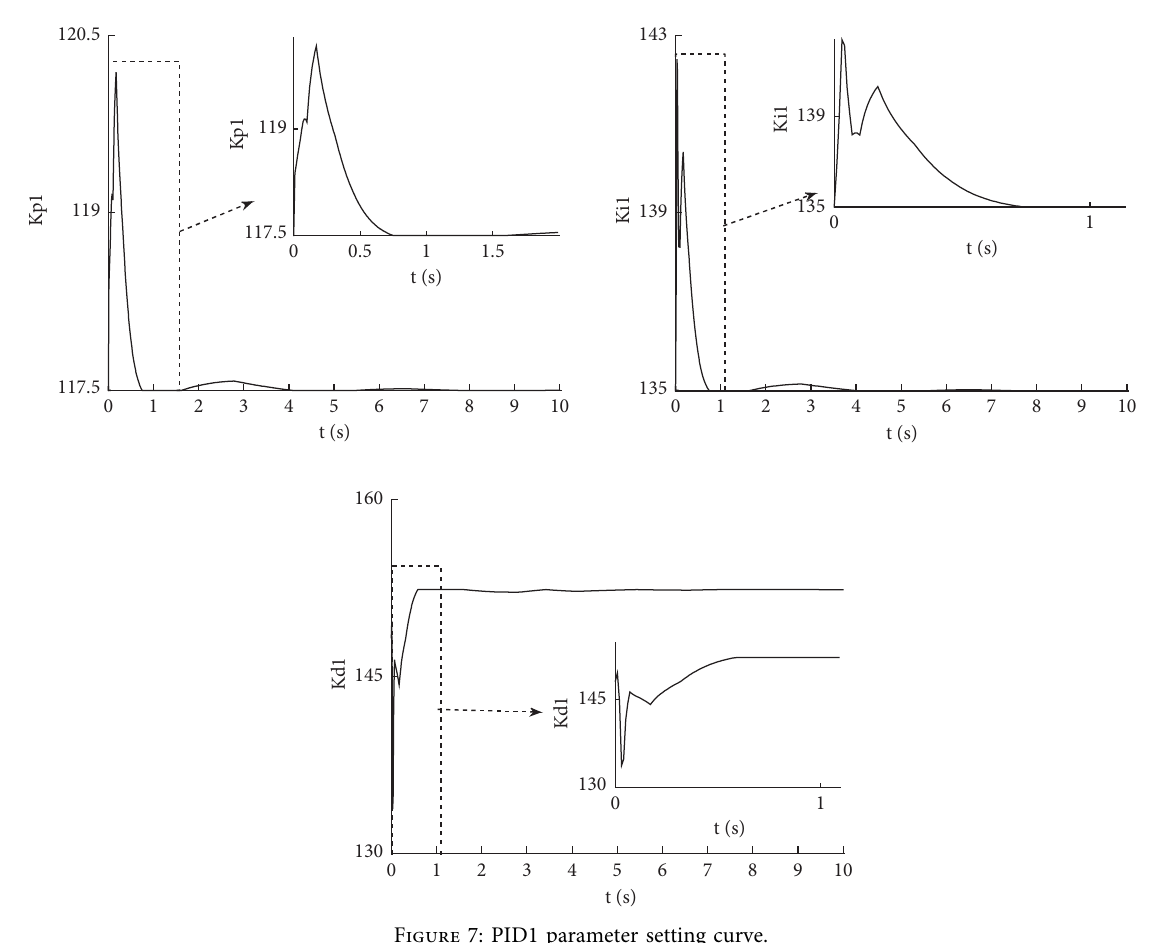
Figure 7: PID1 parameter setting